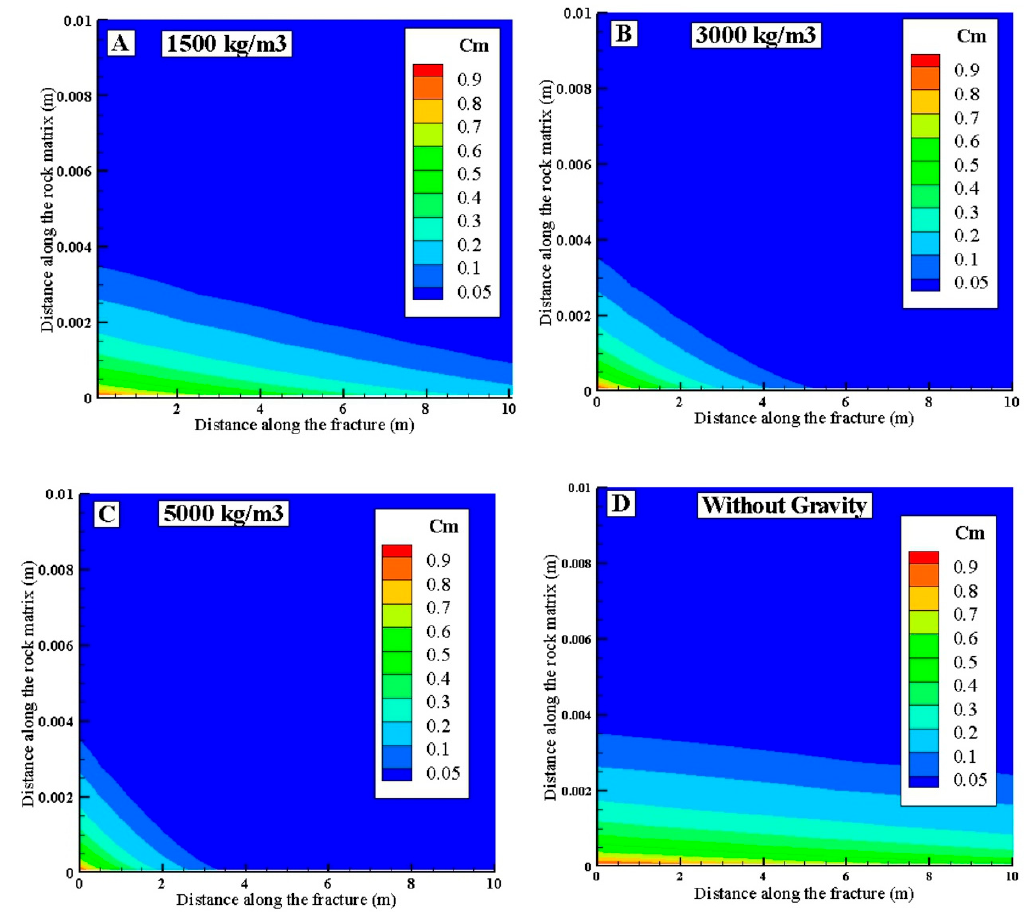
Figure 6. Contour plots depicting the diffusion of colloids within the rock matrix for three different values of colloid density 1500 (6A), 3000 (6B), and 5000 kg/m 3 (6C) and for no gravitational force (6D) at 300 nm colloid size.